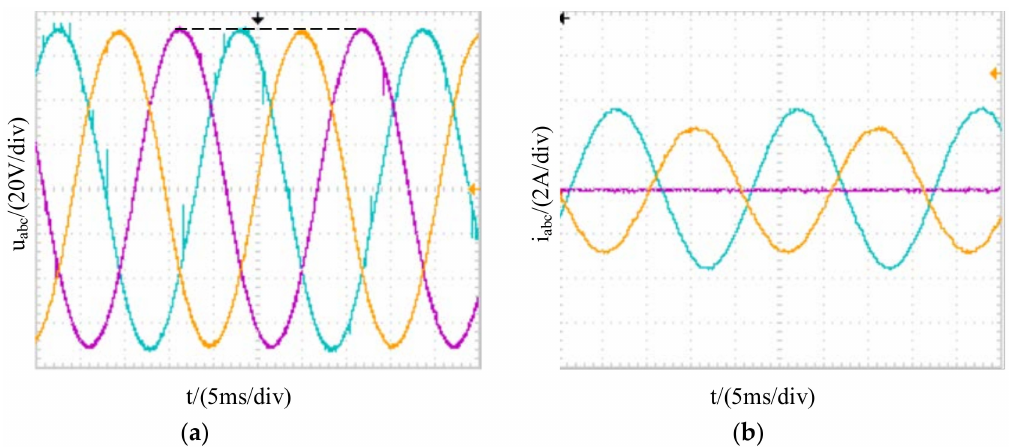
Figure 16. Three-phase output voltages and currents with improved droop control and impedance-drop compensation control in the case of an unbalanced load. ( a ) Voltage waveforms; ( b ) Current waveforms.